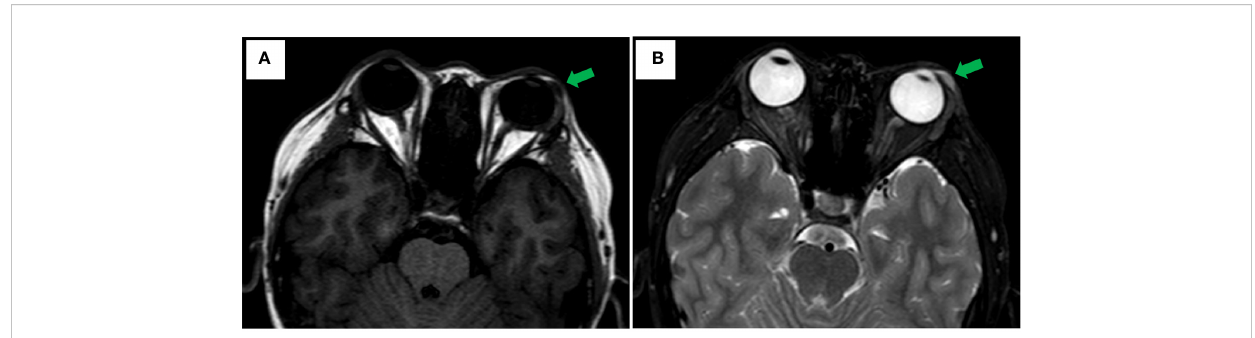
FIGURE 1 Axial MRI Imaging. (A) Well-circumscribed fusiformmass is noted in the left lower eyelid appearing hypointense on T1 weighted image with green arrowhead. (B) T2-weighted showing hyperintense with green